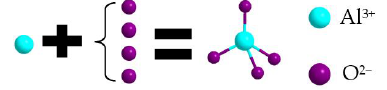
Figure 19. The schematic diagram of Equation (4).